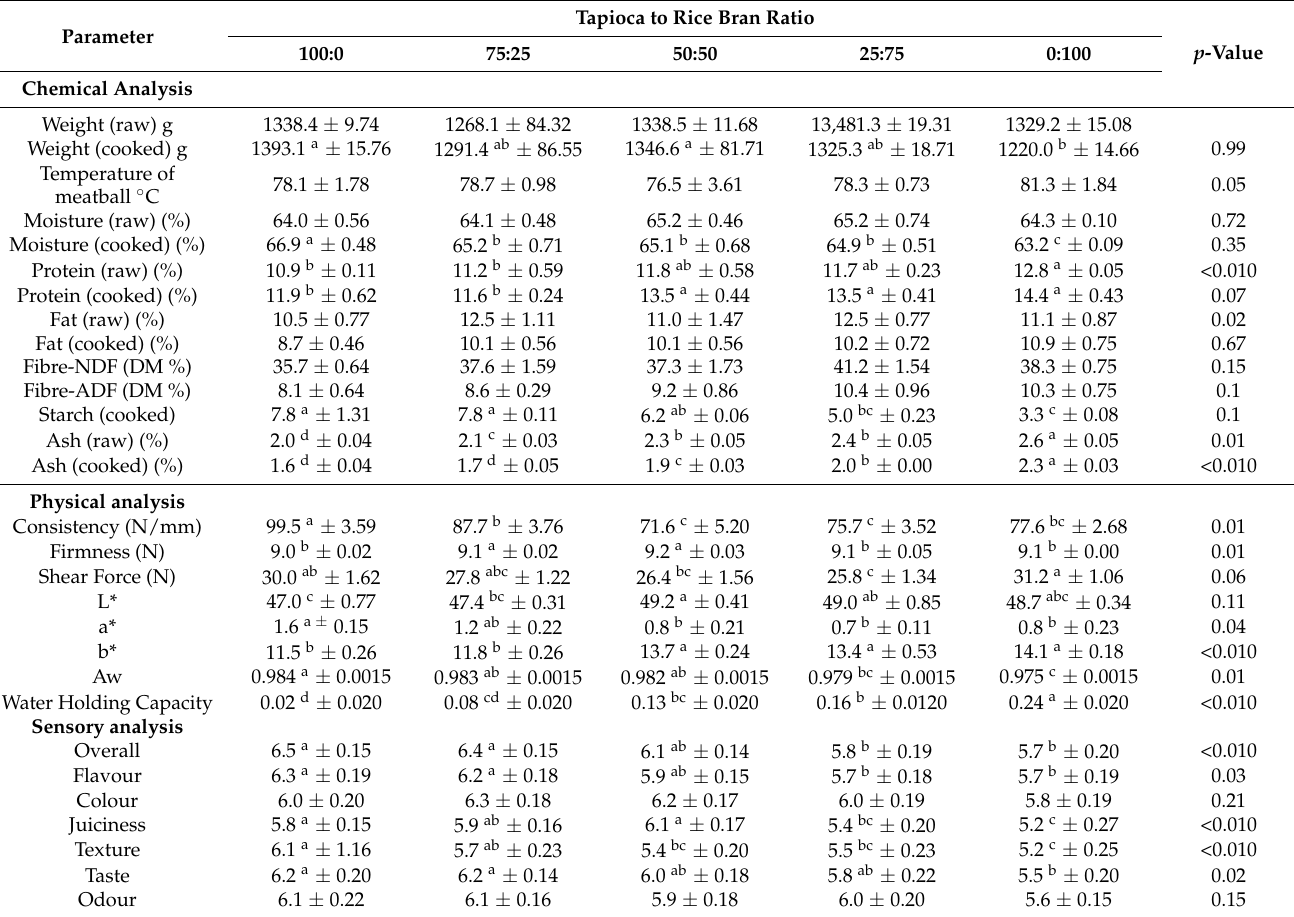
Table 4. Mean ( ± s.e.) chemical, physical, and sensory values for goat meatballs made with varying ratios of tapioca and rice